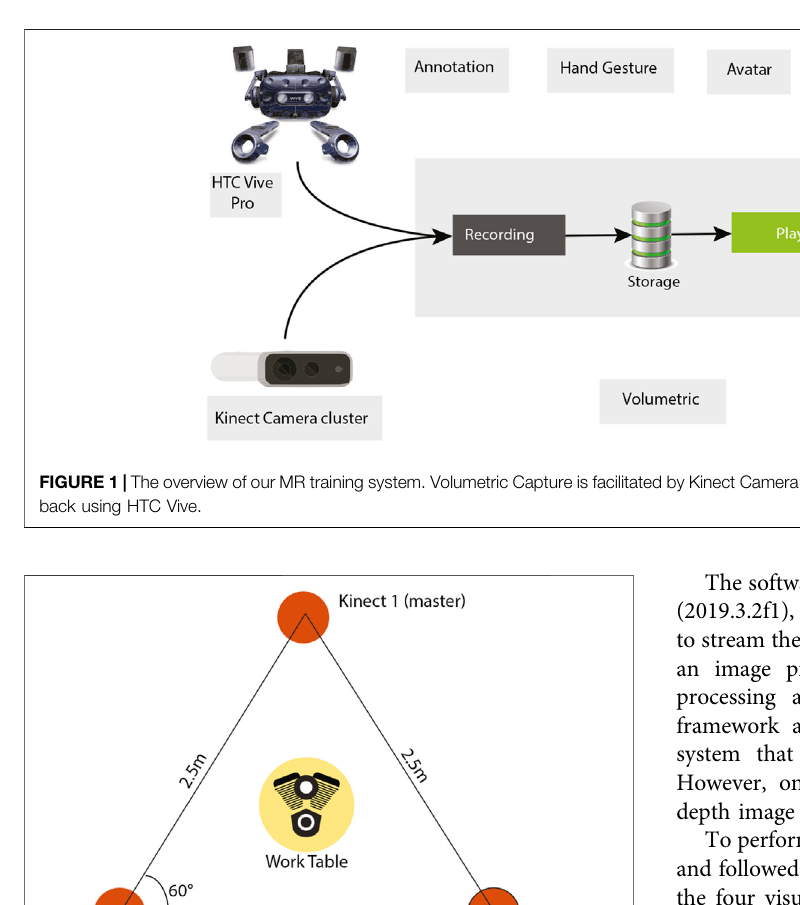
Frontiers in Virtual Reality |